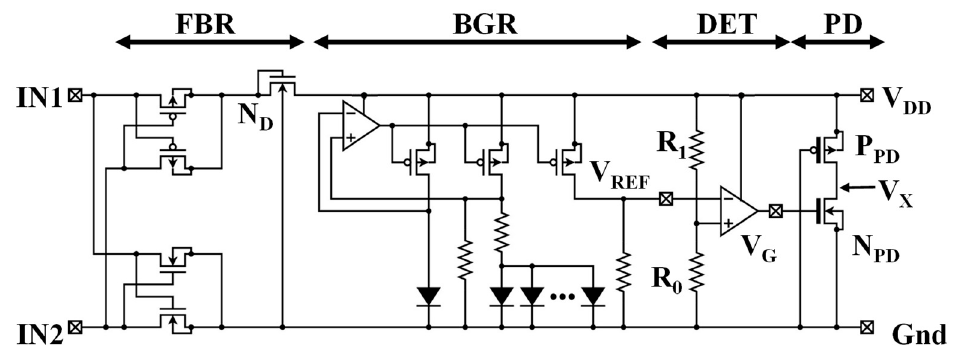
Figure 2. AC-DC converter for an ES-EH proposed in this